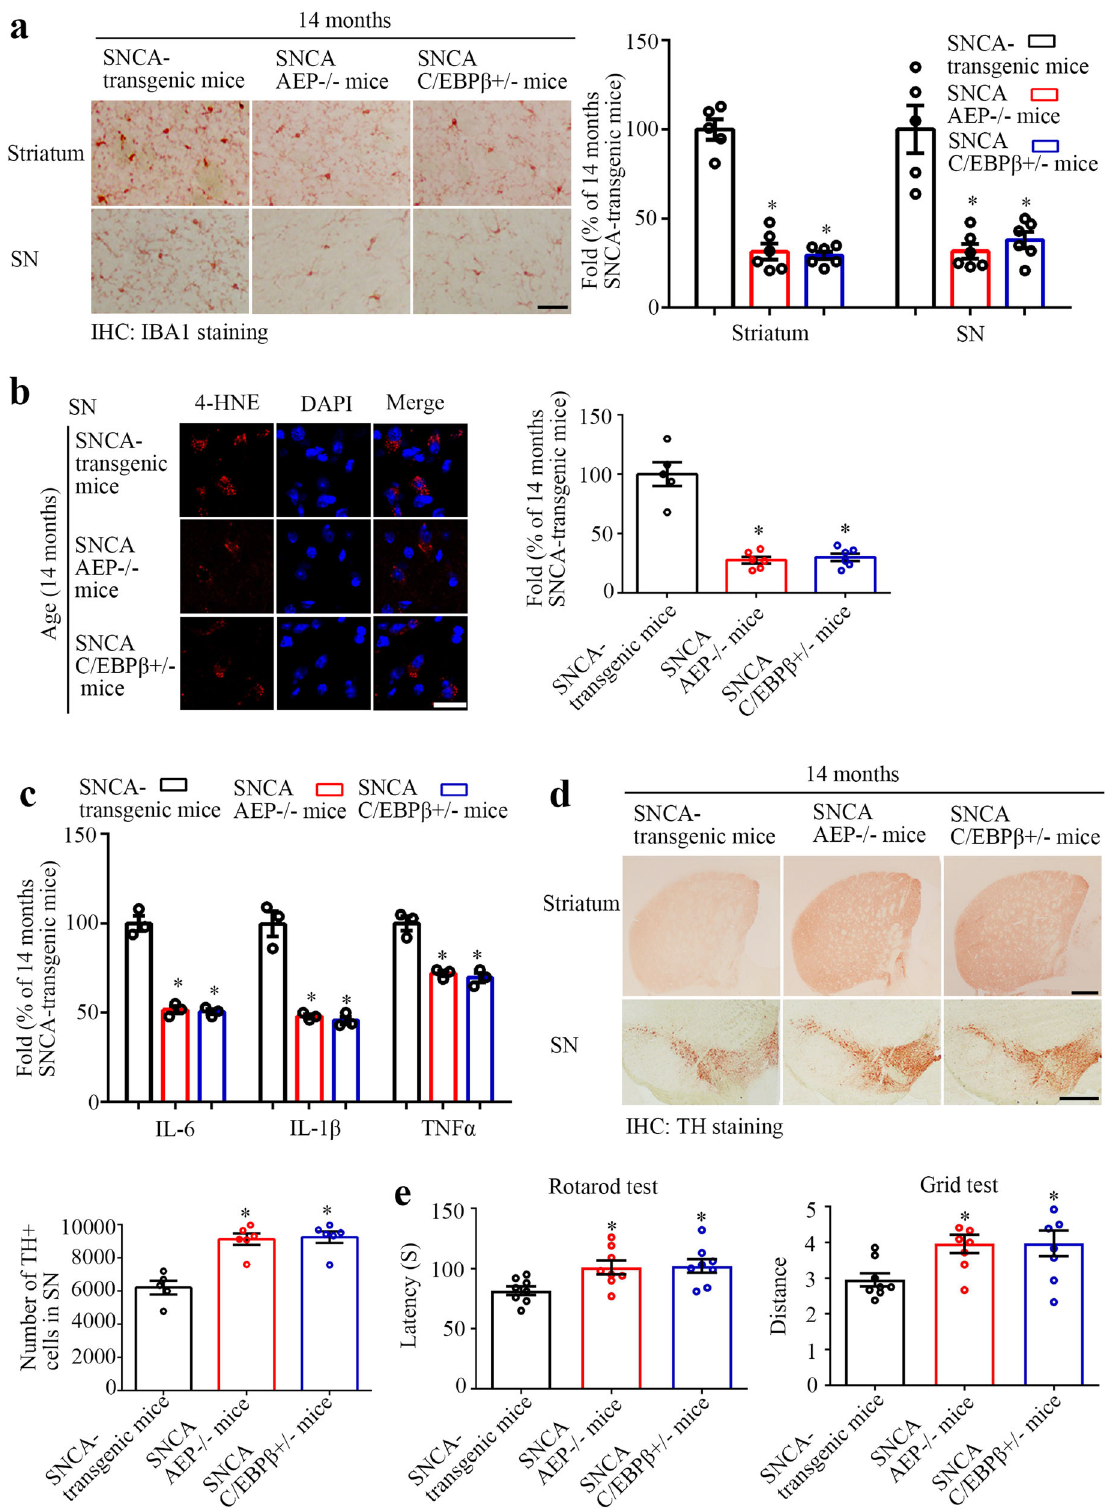
Fig. 3 C/EBP β /AEP pathway mediates neuro-in fl ammation in α -SNCA transgenic mice. a Immunostaining and the quanti fi cation of Iba-1 in the striatum and SN. ( n = 5 – 6 per group, * P < 0.05 vs 14 months old α -SNCA transgenic mouse, one-way ANOVA). Scale bar, 50 μ m. b 4-HNE staining and the quanti fi cation in the SN. ( n = 5 – 6 per group, * P < 0.05 vs 14 months old α -SNCA transgenic mouse, one-way ANOVA). Scale bar, 20 μ m. c Reduction of C/EBP β and knockdown of delta-secretase decreases the expression levels of in fl ammatory cytokines in α -SNCA transgenic mice. ( n = 3 per group, * P < 0.05 vs 14 months old α -SNCA transgenic mouse, one-way ANOVA). d Immunostaining of TH in the striatum and SN, and the quanti fi cation of TH in SN. ( n = 5 – 6 per group, * P < 0.05 vs 14 months old α -SNCA transgenic mouse, one-way ANOVA). Scale bar, 500 μ m. e Rotarod test and Grid test. (mean ± s.e.m.; n = 8 mice per group; * P < 0.05 vs 14 months old α -SNCA transgenic mouse, one-way ANOVA).